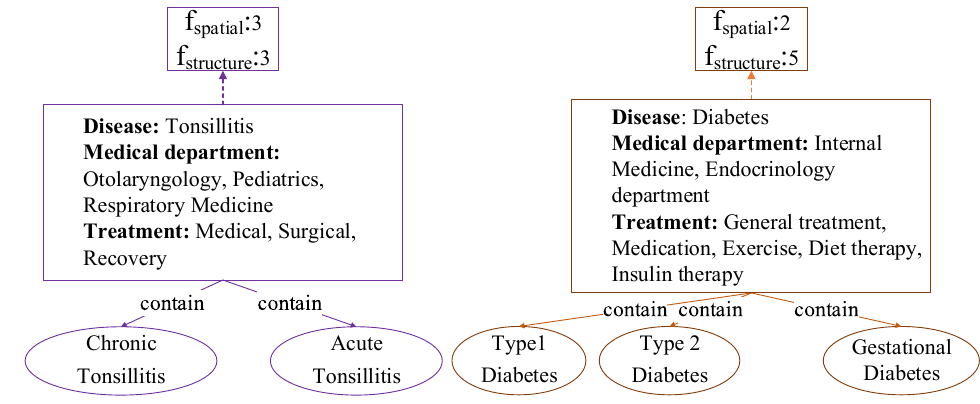
Figure 3. Statistics of Data DIK on f (cid:2929)(cid:2926)(cid:2911)(cid:2930)(cid:2919)(cid:2911)(cid:2922) and f (cid:2929)(cid:2930)(cid:2928)(cid:2931)(cid:2913)(cid:2930)(cid:2931)(cid:2928)(cid:2915) . Figure 3. Statistics of Data DIK on f spatial and f structure